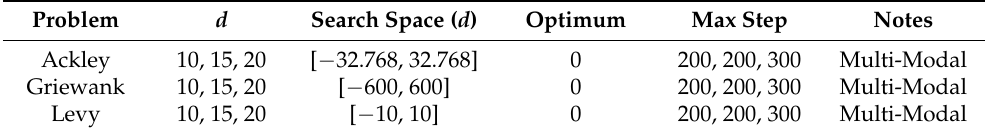
Table 1. The settings of test